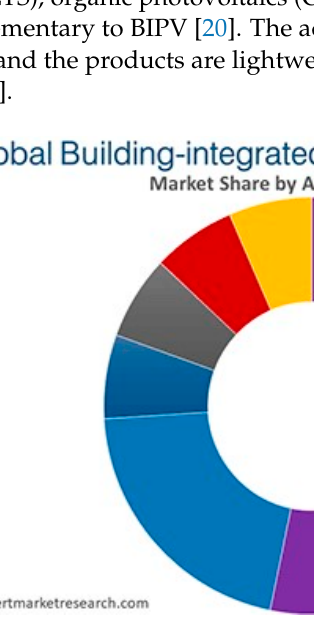
Figure 1. Market segmentation of global building-integrated photovoltaics [13].